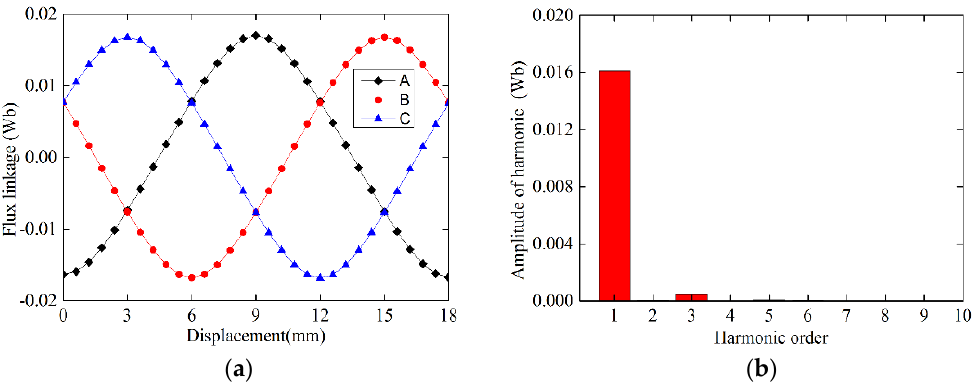
Figure 4. Flux linkage and its harmonics ( a ) Waveforms; ( b ) Harmonics components.